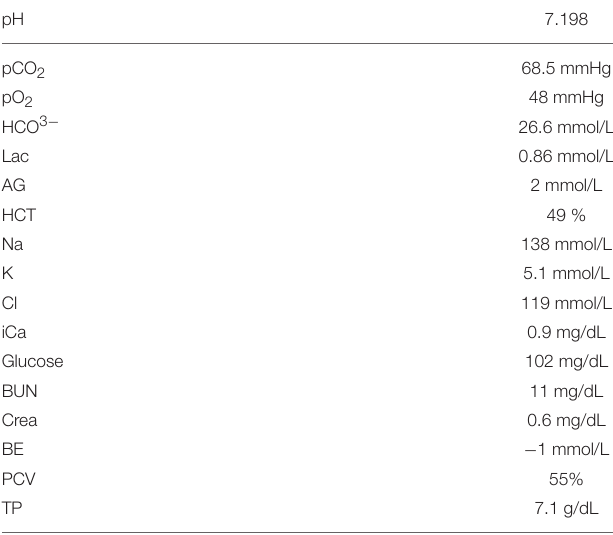
TABLE 1 | iStat obtained at presentation, venous blood sample (Abbott Heska i-STAT Veterinary Clinical Analyzer, Abaxis North America, Union City, CA, USA).